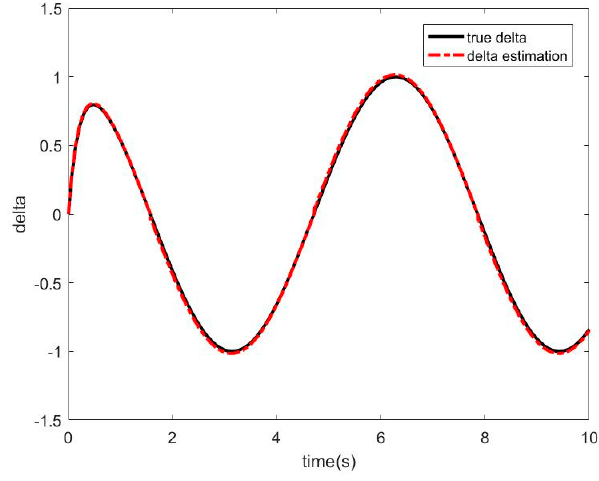
Figure 8. Approximation curve of RBF-NN to frictional disturbance torque.